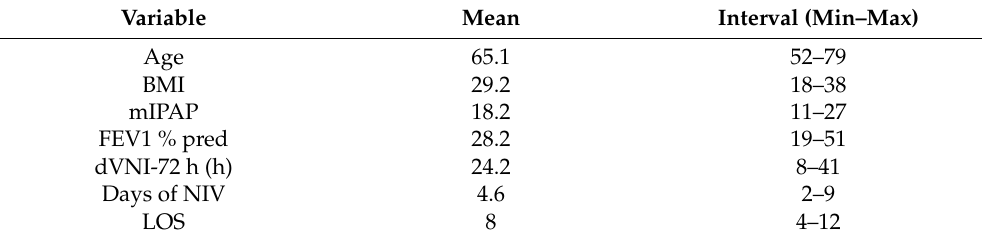
Table 1. Patient characteristics.